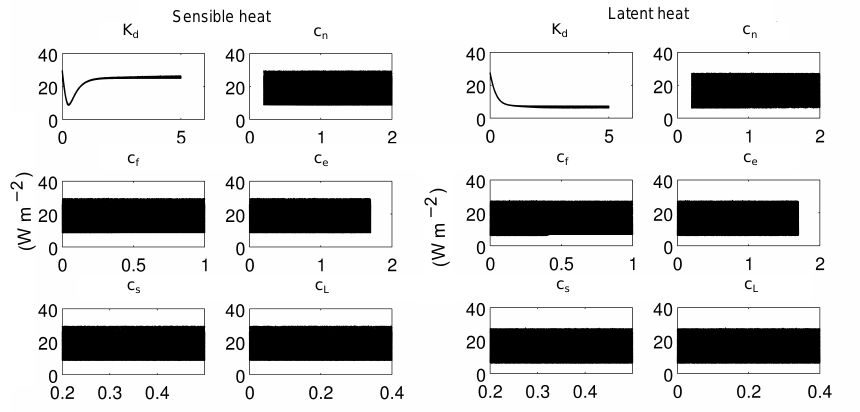
Figure 9. Mean absolute error for sensible and latent heat fluxes, from the GLUE simulations. Each dot represents a simulation with ran- dom parameters. The y axis shows heat flux (Wm − 2 ) and the x axis is the parameter value. Results were similar for the Nash–Sutcliffe performance.